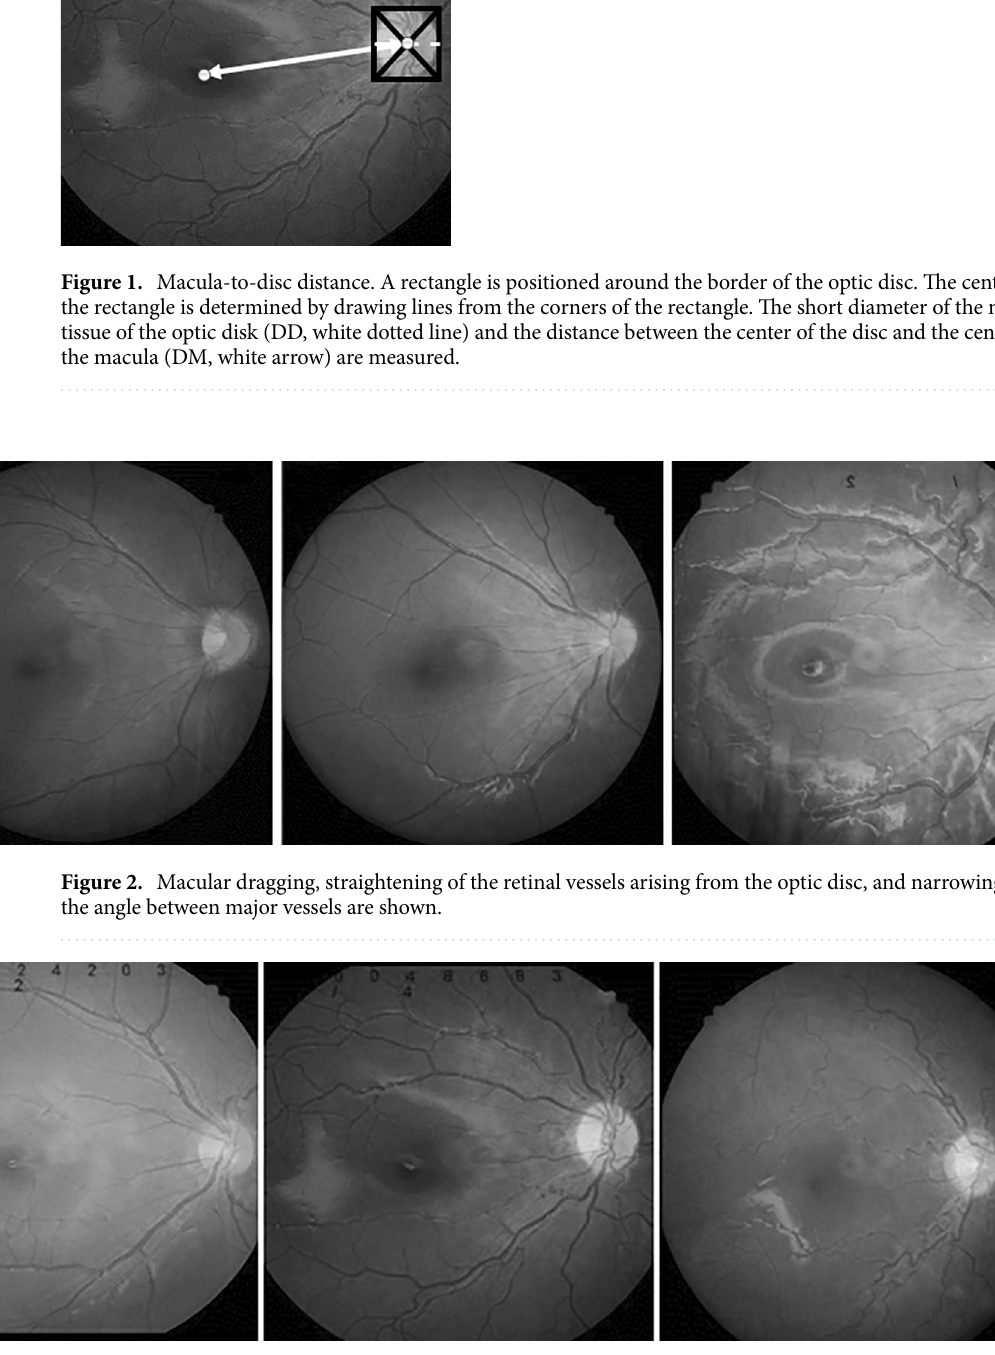
Figure 3. Vascular tortuosity: graded based on standard photographs selected by two ophthalmologists’ consensus (1, no tortuosity; 2, mild to moderate; 3,